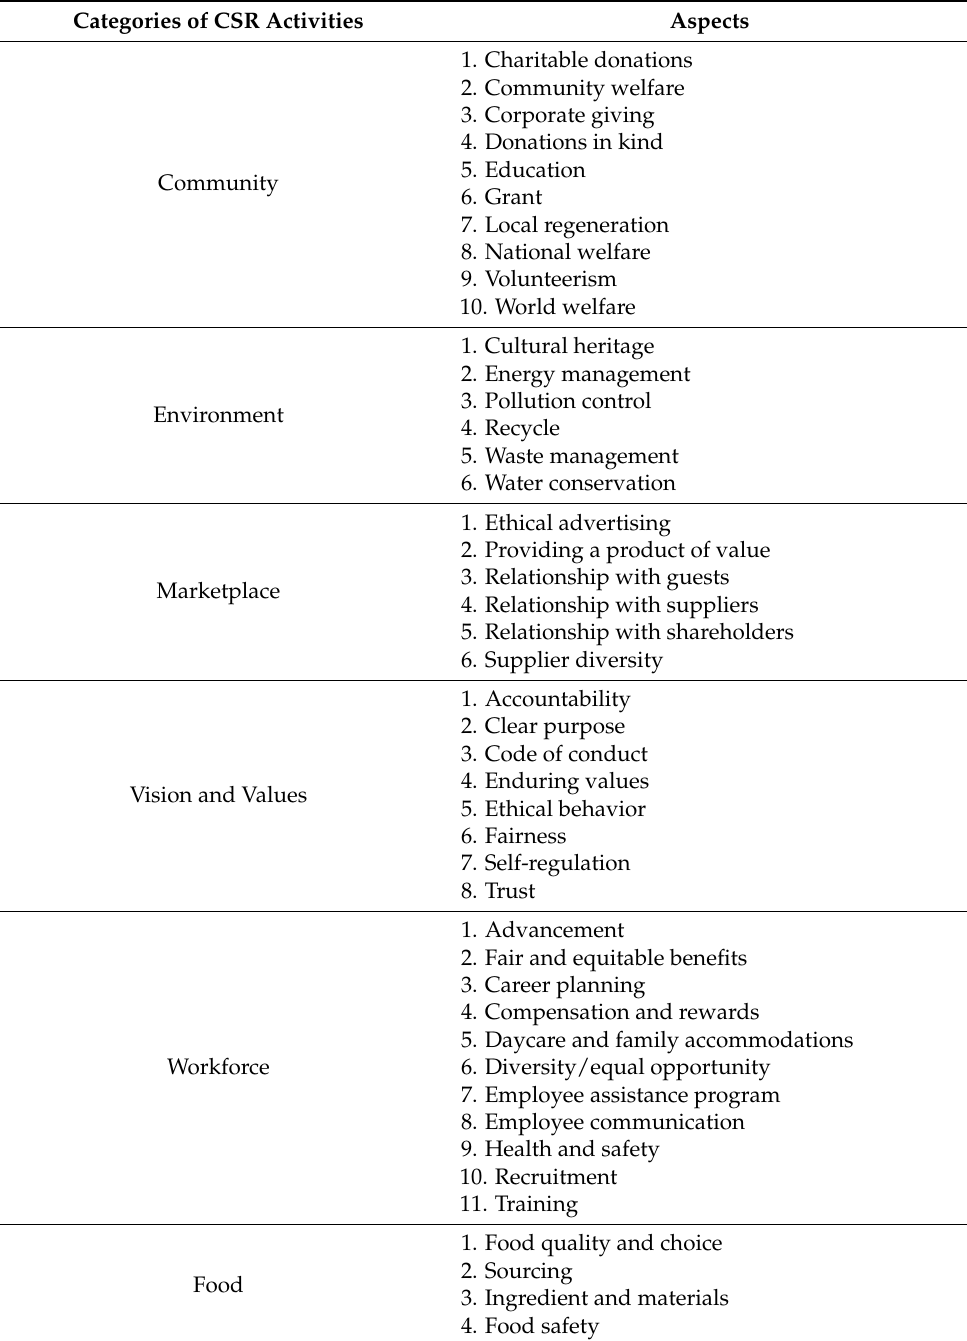
Table 1. Categories of CSR activities (source: Holcomb et al.